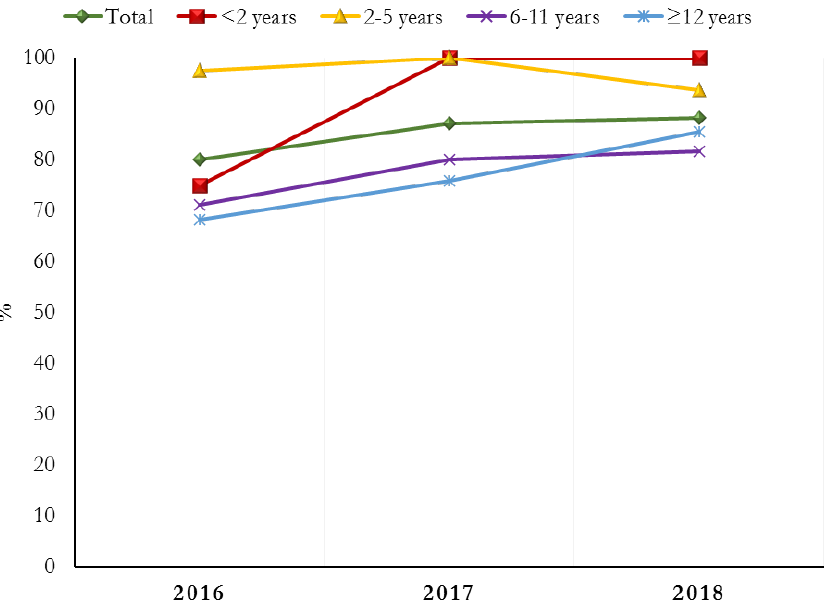
Figure 3. Subjects (%) treated with ranitidine during the study period, stratified by age group.